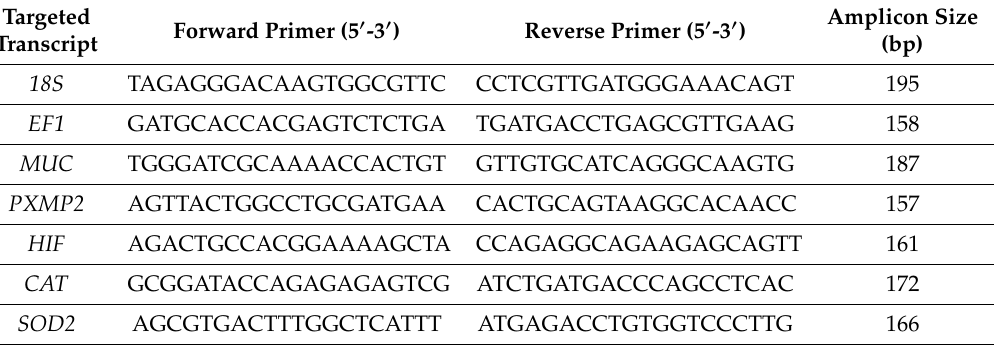
Table 2. Primer pairs used for the isolation of candidate and reference genes from zebrafish